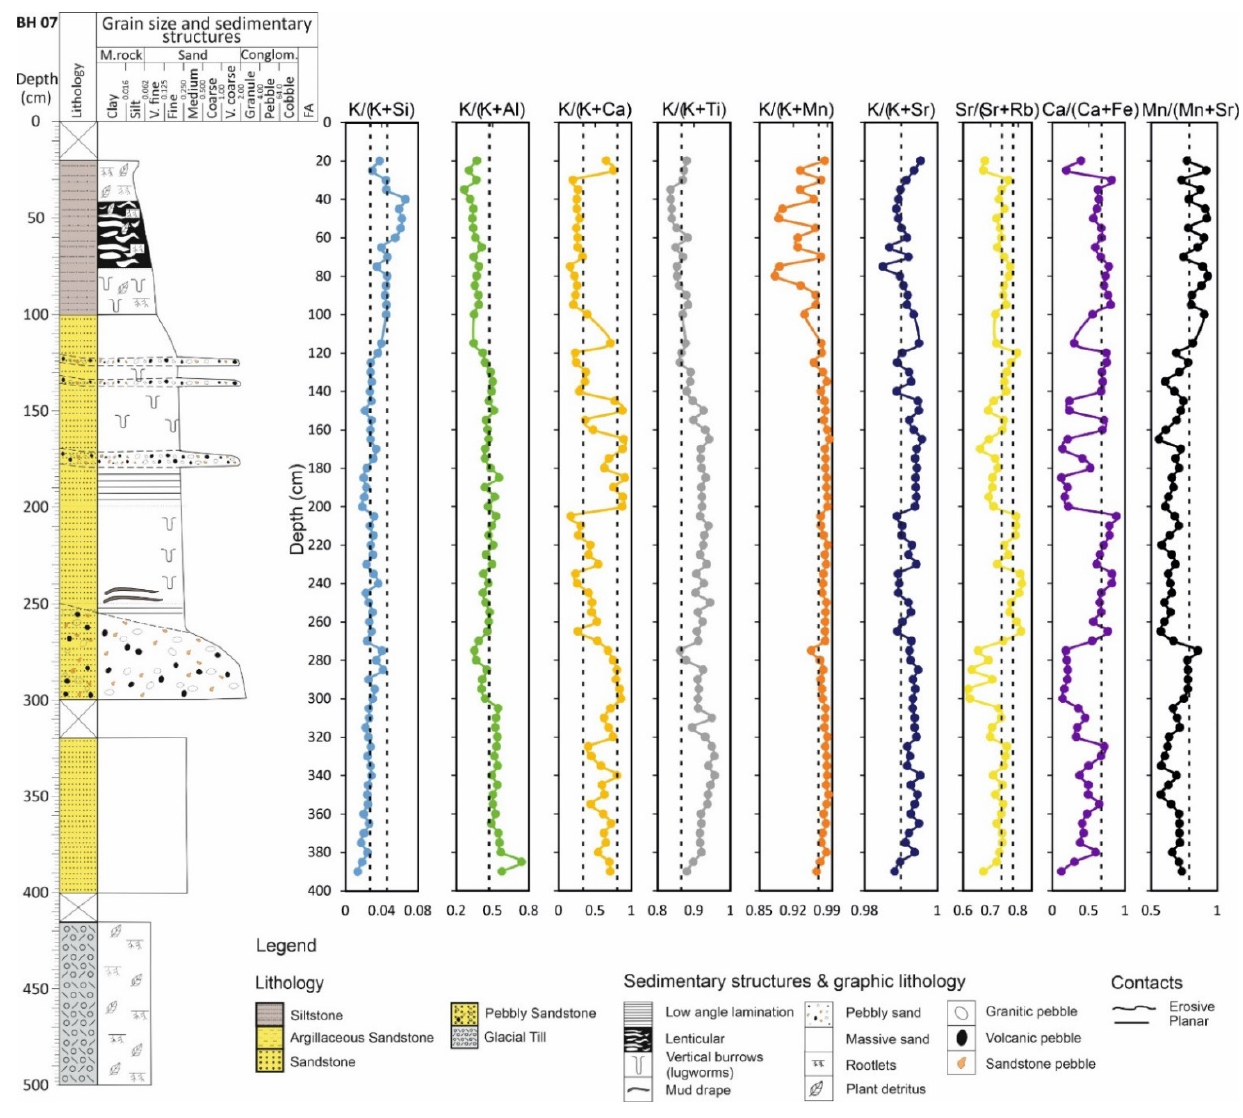
Figure 8. Sedimentary log of the 5 m Holocene core drilled in a tidal bar in the Esk arm of the Ravenglass Estuary (Figures 1 and 2) with the geochemical data, derived from XRF analysis, illustrated. These nine indices are represented as these are the ones that RPART classification, in R Statistical Software, used to discriminate the various sub-depositional environments (e.g., Section 5.5 and Figure 9). The critical values superimposed on the nine indices, were taken from machine learning-derived decision nodes in Figure 9.